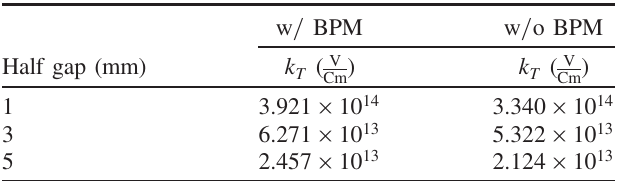
TABLE I. Geometric transverse kick factors due to the LHC Run I and Run II TCS/TCT geometries, calculated at different half gap values.